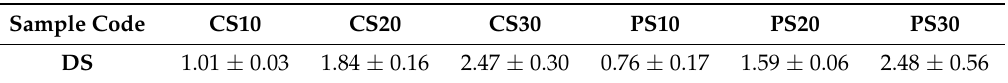
Table 3. The DS of starch aldehydes (mean ± SD, n =